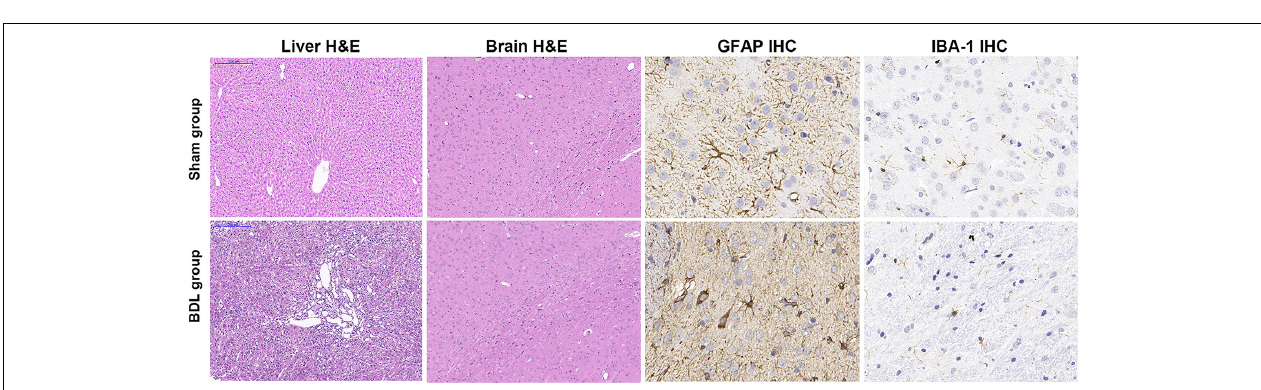
FIGURE 3 | Representative H&E staining and IHC findings in sham and BDL rats. Liver H&E staining (100 × magnification) showed normal hepatic histology in the sham group. Staining in the BDL group showed destroyed hepatic cords, expanded bile duct, and inflammatory infiltration. H&E staining (100 × ) of brain